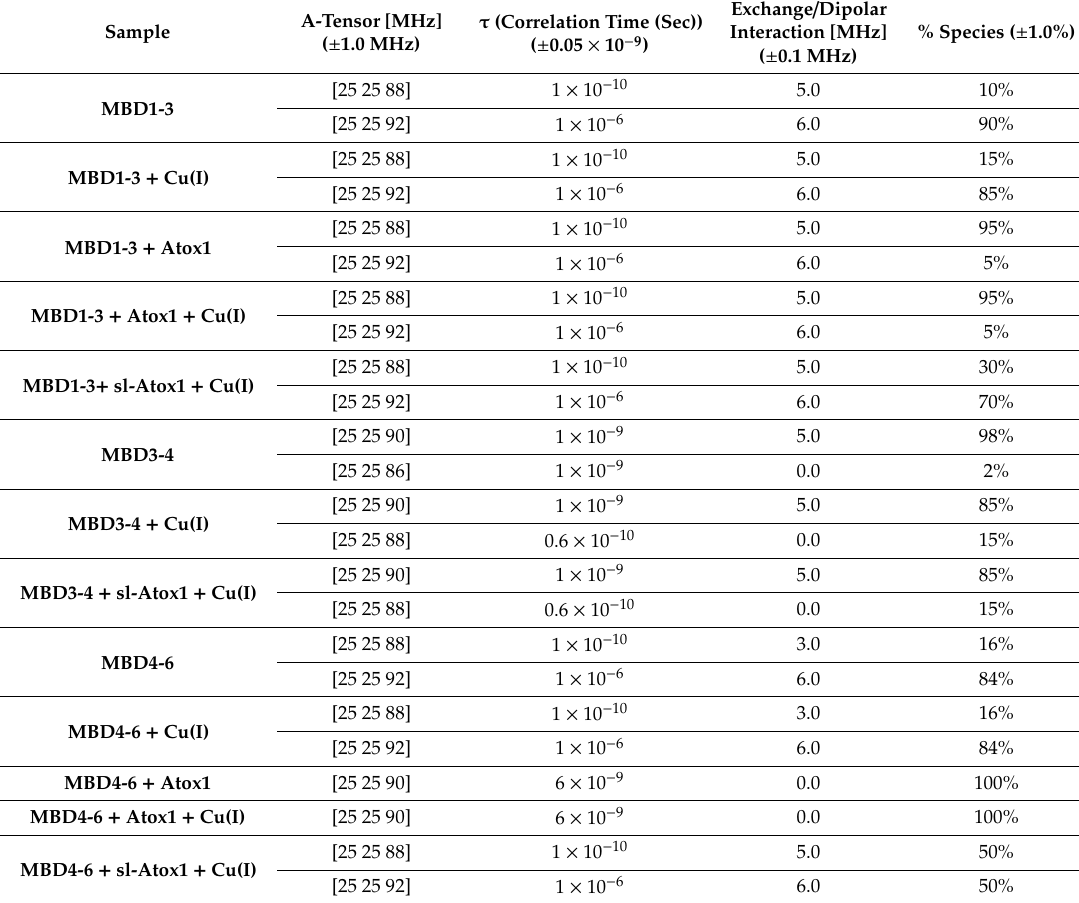
Table 1. Simulated parameters for CW-EPR spectra obtained with the easyspin, chili method, in the presence of two species at a g tensor of [2.0087 2.006 2.0022].